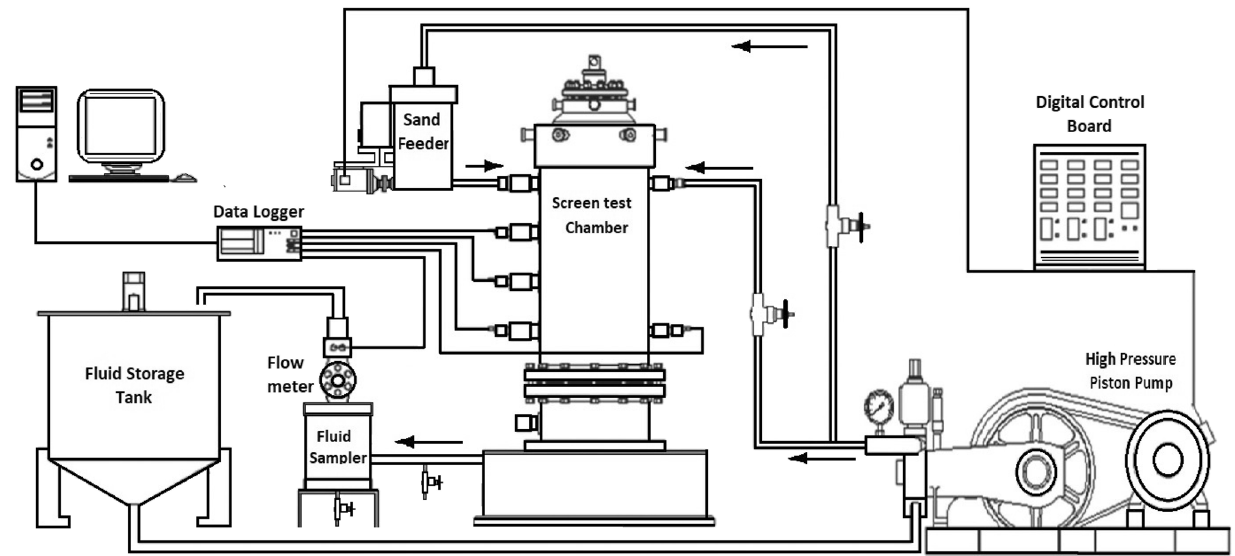
Fig. 3 Schematic diagram of a sand retention apparatus. Modified after Changyin et al.